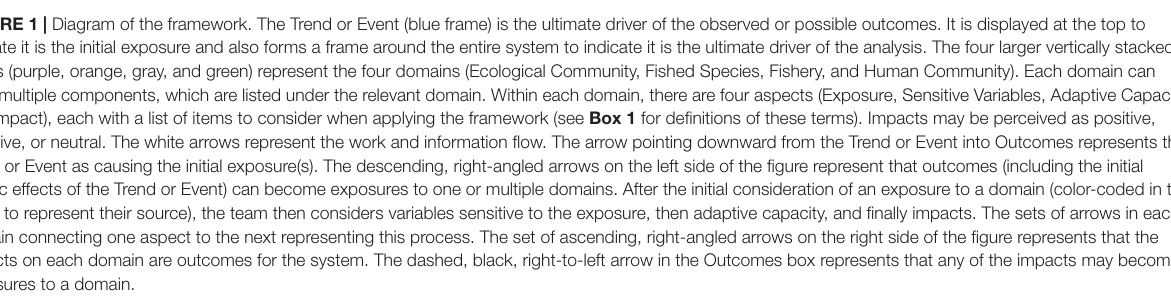
FIGURE 1 | Diagram of the framework. The Trend or Event (blue frame) is the ultimate driver of the observed or possible outcomes. It is displayed at the top to indicate it is the initial exposure and also forms a frame around the entire system to indicate it is the ultimate driver of the analysis. The four larger vertically stacked boxes (purple, orange, gray, and green) represent the four domains (Ecological Community, Fished Species, Fishery, and Human Community). Each domain can have multiple components, which are listed under the relevant domain. Within each domain, there are four aspects (Exposure, Sensitive Variables, Adaptive Capacity, and Impact), each with a list of items to consider when applying the framework (see Box 1 for definitions of these terms). Impacts may be perceived as positive, negative, or neutral. The white arrows represent the work and information flow. The arrow pointing downward from the Trend or Event into Outcomes represents the Trend or Event as causing the initial exposure(s). The descending, right-angled arrows on the left side of the figure represent that outcomes (including the initial abiotic effects of the Trend or Event) can become exposures to one or multiple domains. After the initial consideration of an exposure to a domain (color-coded in the figure to represent their source), the team then considers variables sensitive to the exposure, then adaptive capacity, and finally impacts. The sets of arrows in each domain connecting one aspect to the next representing this process. The set of ascending, right-angled arrows on the right side of the figure represents that the impacts on each domain are outcomes for the system. The dashed, black, right-to-left arrow in the Outcomes box represents that any of the impacts may become exposures to a